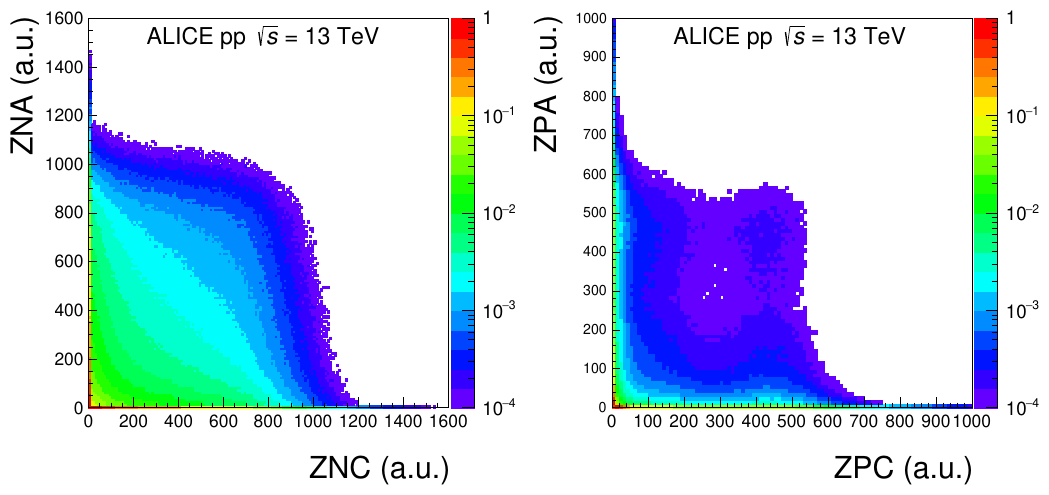
Figure 1 . A- vs. C-side signal in ZN (left) and ZP (right). The maximum at (0,0) is normalised to unity, while the minimum is limited to 10 − 4